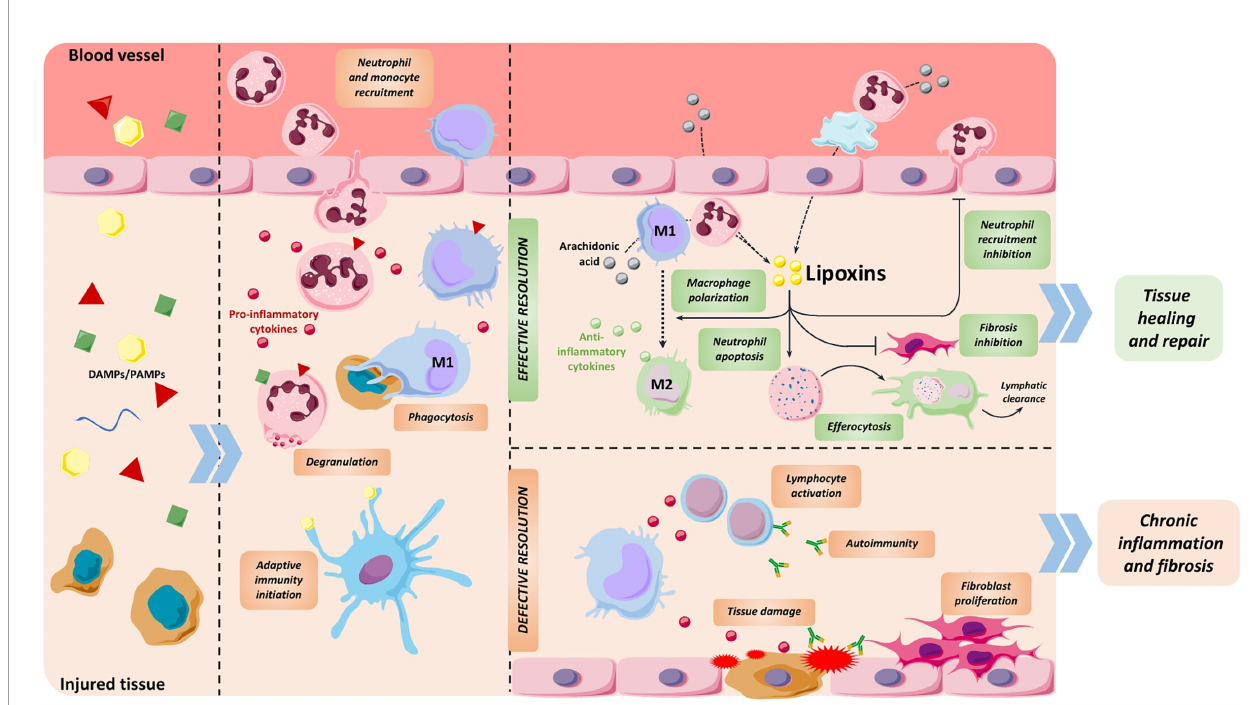
FIGURE 1 | Stages of in fl ammatory process. Release of pathogen and damage-associated molecular patterns (PAMPs and DAMPs) from injured tissue initiates in fl ammation by promoting the recruitment of neutrophils followed by monocytes. These immune cells blunt the source of damage by exerting different functions like degranulation to release toxic substances, phagocytosis, release of pro-in fl ammatory cytokines and initiating antigen recognition. At the end of this phase, immune cells shift to a resolutive phenotype, generating LXs and other specialized pro-resolving mediators that support the end of the in fl ammatory response. During resolution, these compounds prevent neutrophil recruitment and induce their apoptosis, polarize macrophages towards an anti-in fl ammatory phenotype, promote efferocytosis and inhibit fi broblast proliferation, among other functions. As a result, tissue is appropriately repaired. If the resolution phase is defective or insuf fi cient, pro-in fl ammatory stimuli persist and end up damaging the tissue, causing chronic in fl ammation and subsequent fi brosis and organ dysfunction.